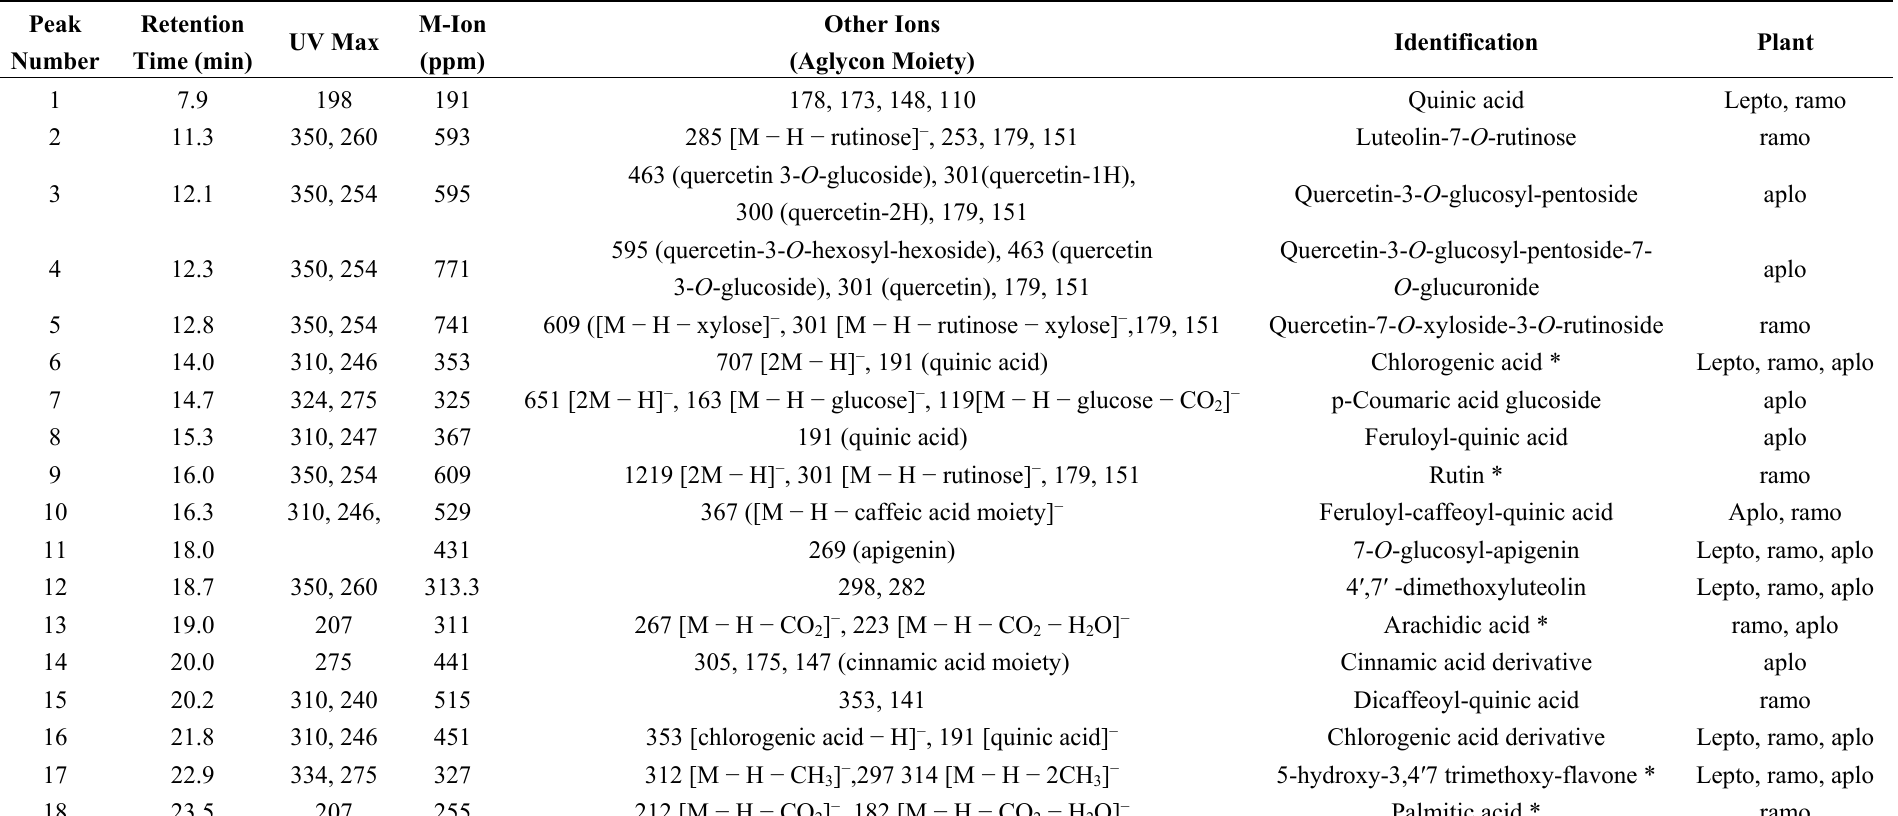
Table 1. HPLC-PDA-ESI-MS n data of Nolana leptophylla ; N. aplocaryoides and N. ramosissima ethyl acetate extracts.